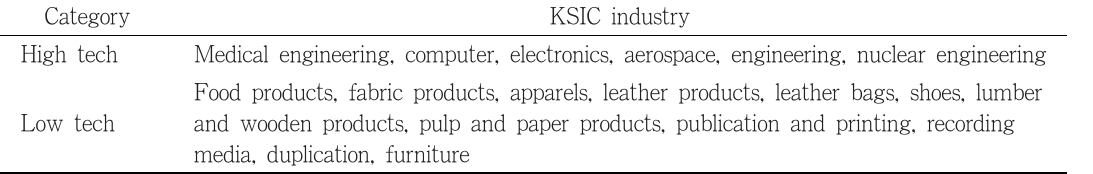
<Table 1> Modified Categories of Korea Standard Industrial Classification (KSIC) according to the Level of Technological Intensity (Oh, Cho, and Kim